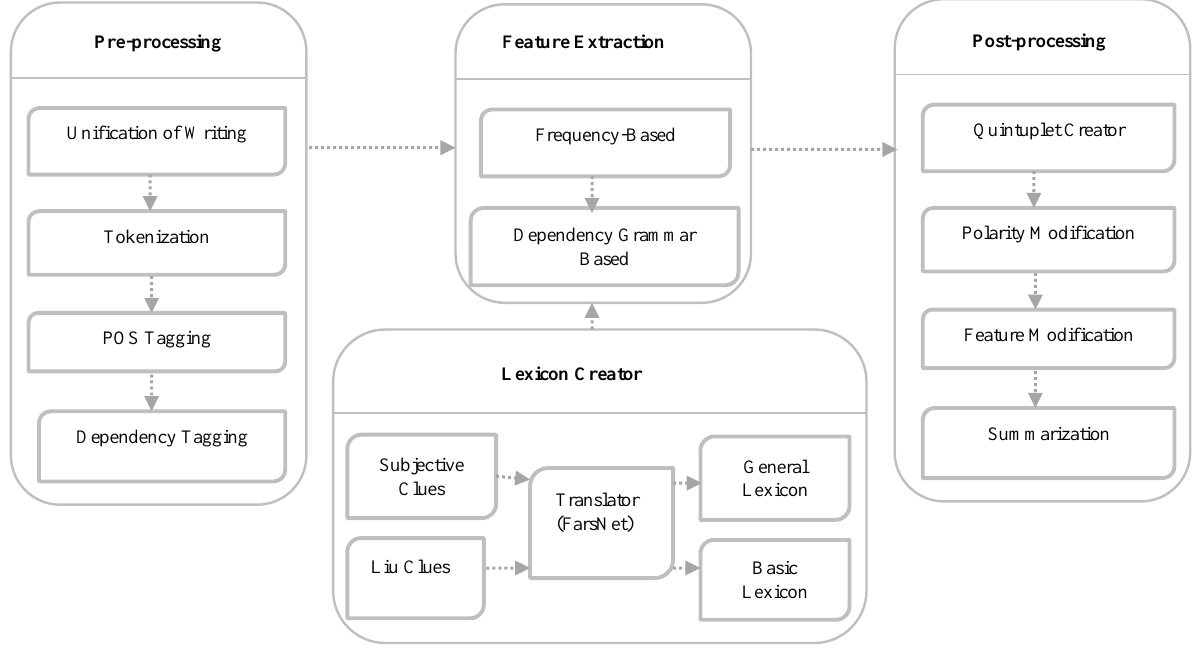
Figure 1. Overview of the suggested